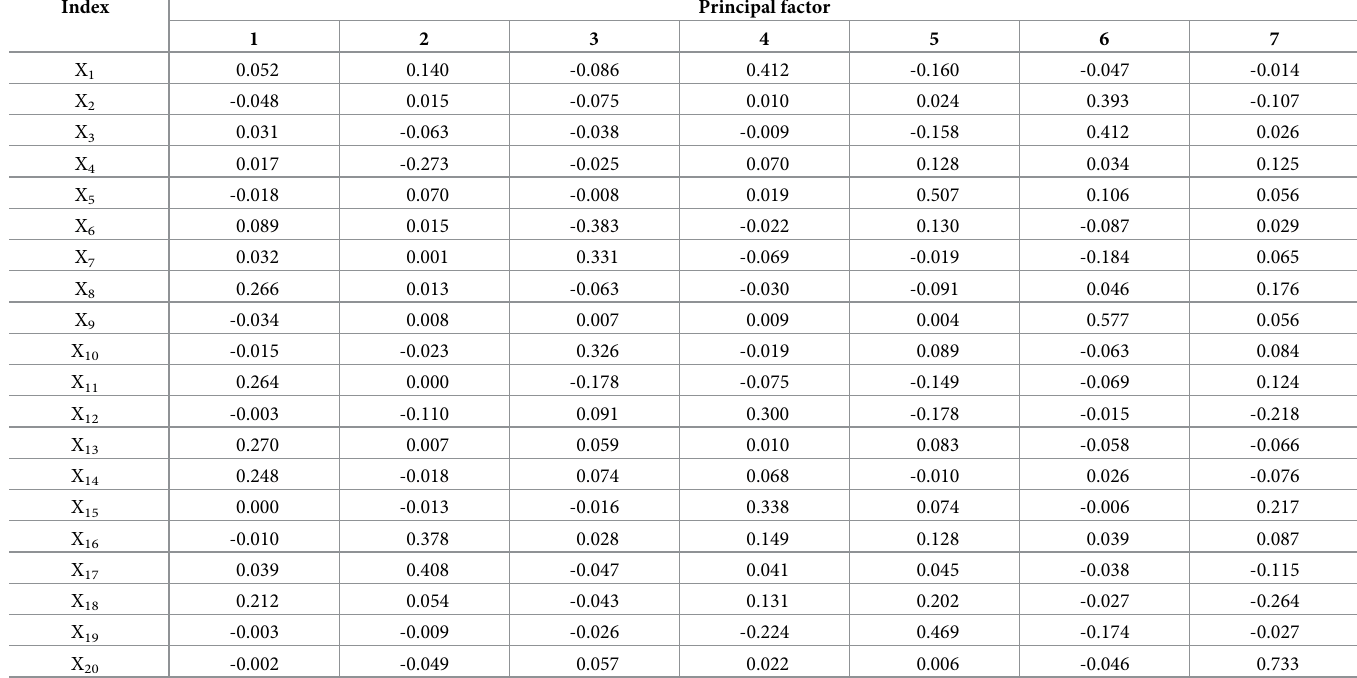
Table 6. Factor score coefficient